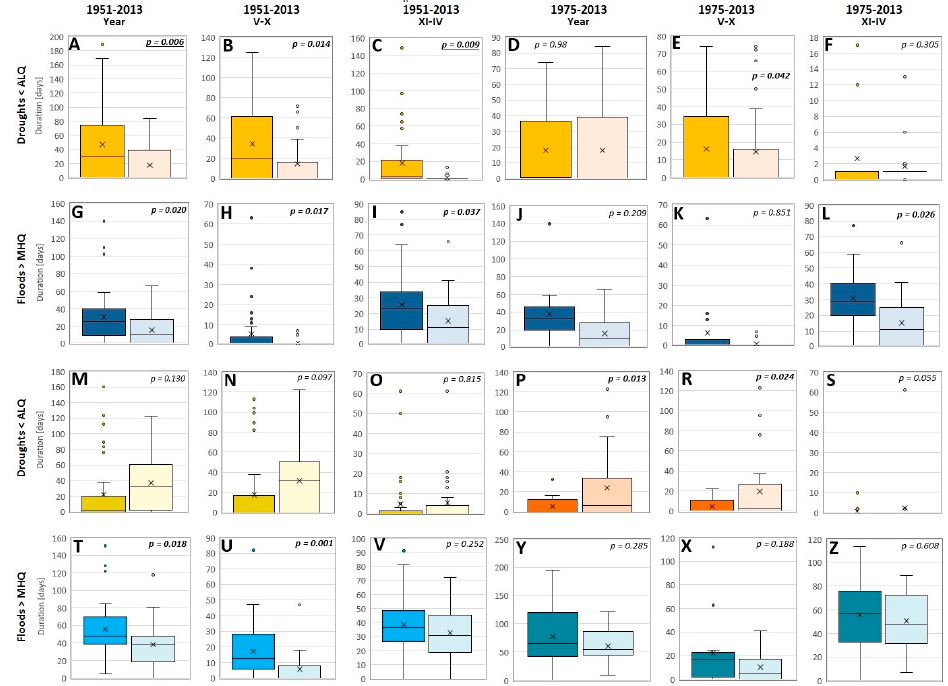
Figure 10. Comparison of the “before” (1951–1988/1975–1988) and “after” (1989–2013) durations of droughts (Q < ALQ; orange/yellow) and floods (Q > MHQ; blue/dark blue) for Narew–Sura ż ( A – L ),